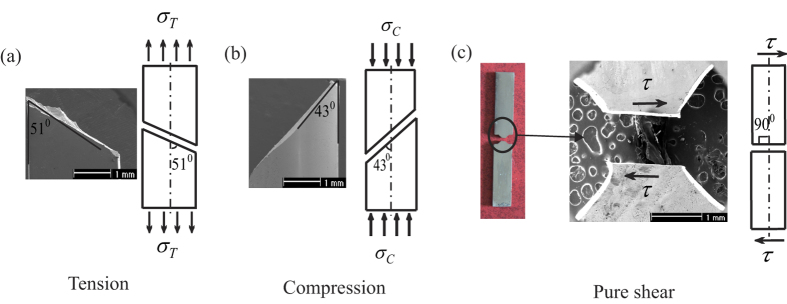
SEM images and schematic diagrams of fracture angle for Zr52.5Cu17.9Ni14.6Al10Ti5 under different loading modes.(a) Tension. (b) Compression. (c) Pure shear.